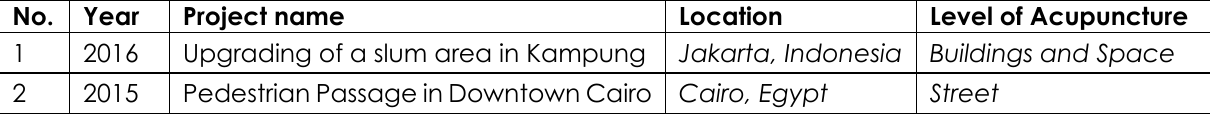
Table 3. Locations of selected international examples of Urban Acupuncture. No.